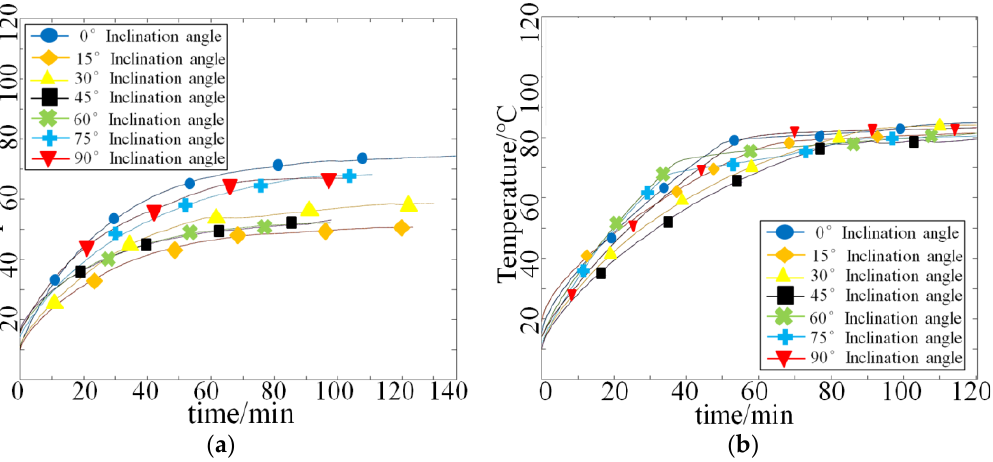
Figure 7. Average temperature profiles at different inclination angles for heat flow density of 444 W·m −2 and 1333 W·m −2 . ( a ) q = 444 W·m −2 , ( b ) q = 1333 W·m